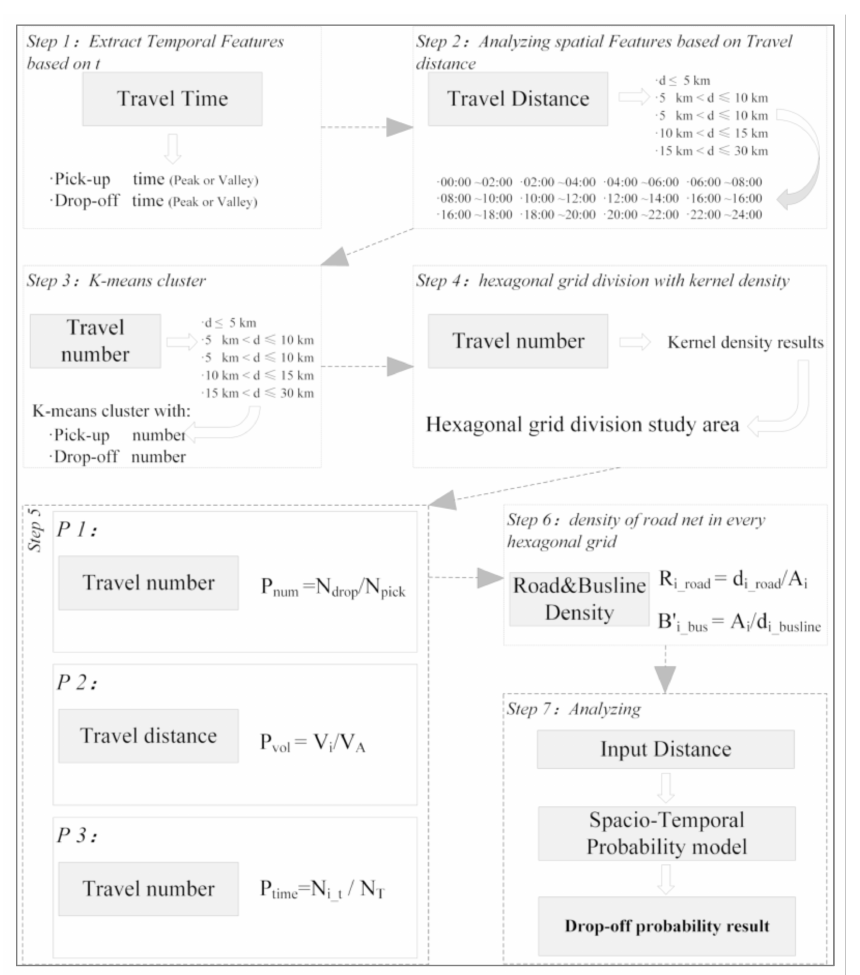
Figure 1. Workflow of the location visited prediction, using the spatiotemporal probability